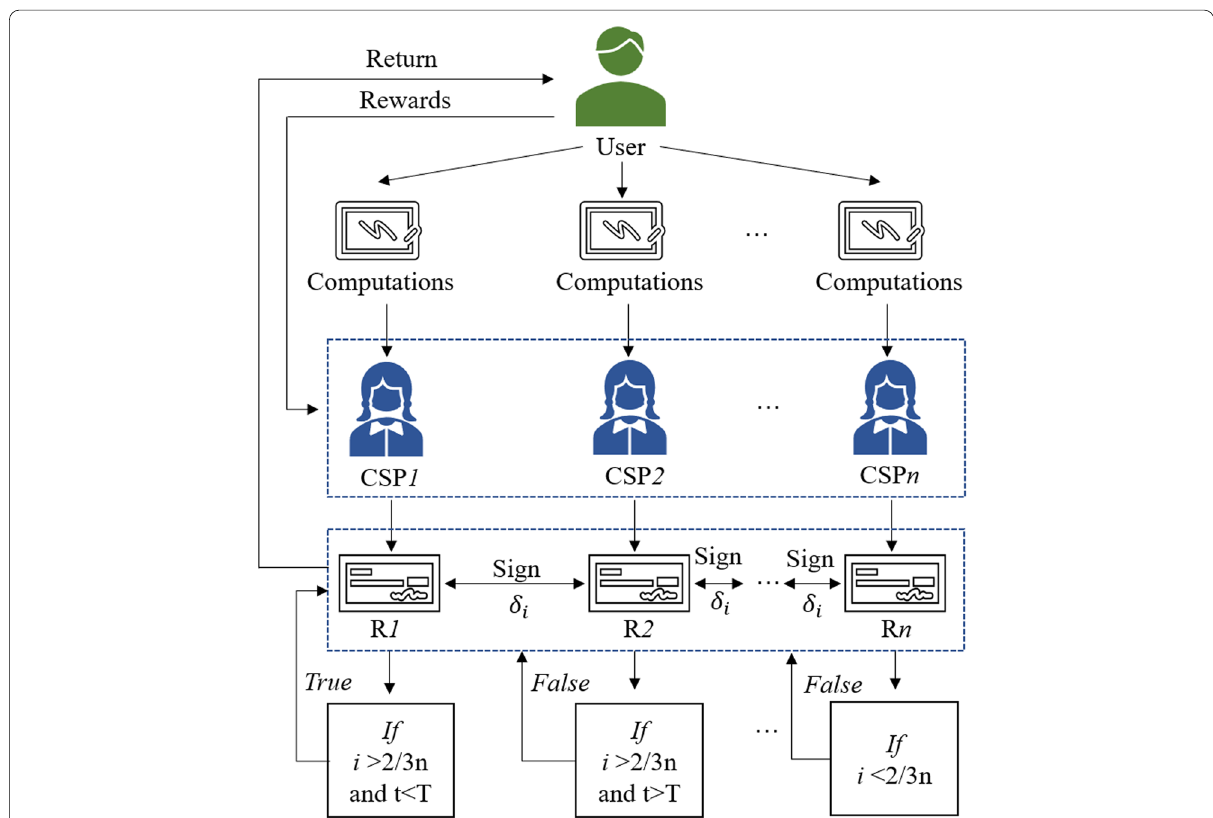
Fig. 1 The application of MPKC-DVMS in